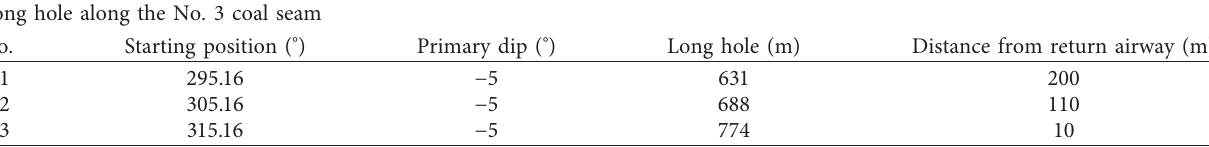
Table 3: Design parameters of three-dimensional pumping directional drilling.